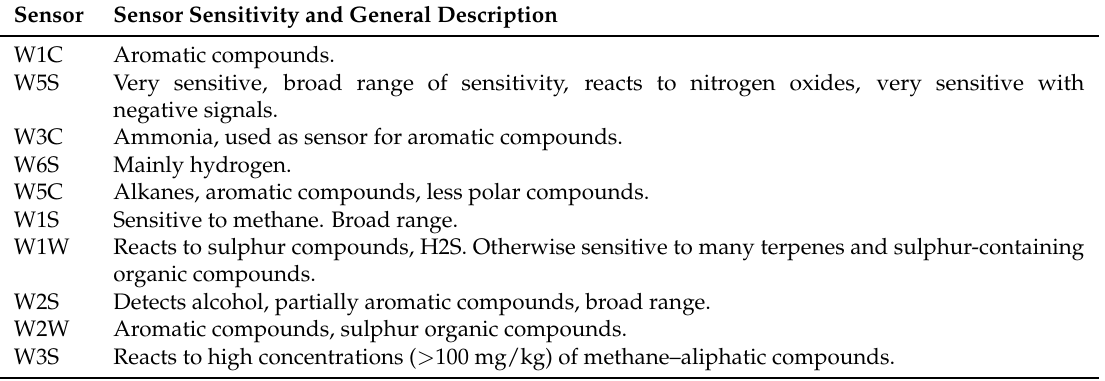
Table 4. The sensor array of the electronic nose.